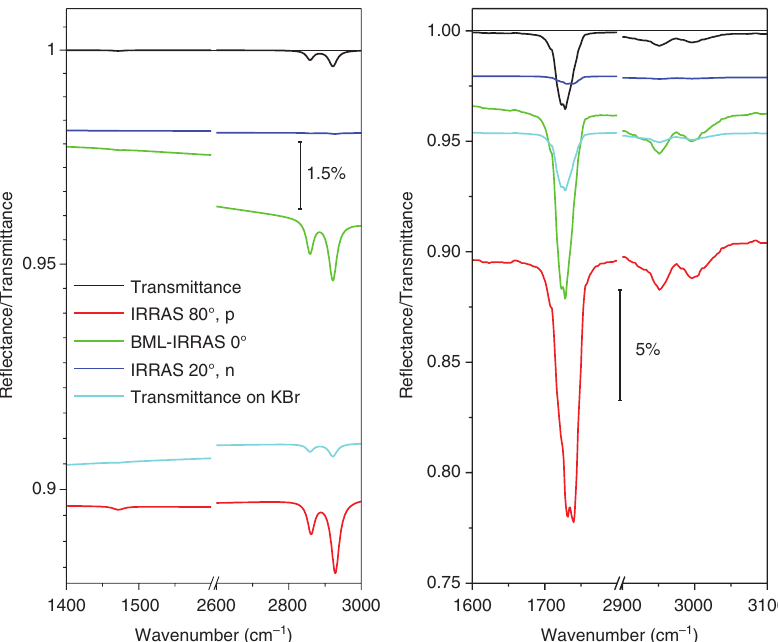
Figure 4: Comparison of the signal strength of 2 nm-thick PE (left) and 30 nm-thick PMMA (right) in the form of a free-standing film in transmittance (black curve), on KBr in transmittance (turquoise curve), on gold with an angle of incidence of 80 ° and parallel polarization in reflectance (red curve), on gold with an angle of incidence of 20 ° and non-polarized radiation (blue curve) and on a 500 nm (PE) and 700 nm (PMMA)-thick SiO layer on gold with normal incidence in reflectance (green curve). All spectra are calculated based on the respective optical 2 constants and Abelès